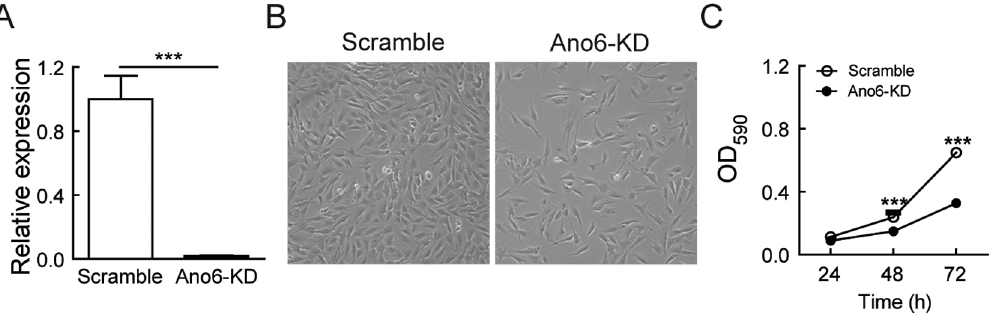
Figure 2. Effects of Ano6 -KD on the proliferation of C2C12 myoblasts. (A) Relative expression of Ano6 (normalized to GAPDH) examined by quantitative RT-PCR in C2C12 stable cells lines (Scramble [shSCR], Ano6 -KD). (B) Representative photographs of stable C2C12 cell lines expressing either a Scramble shRNA or the shRNA targeting Ano6 -KD 48 hours post plating. (C) Quantitative analysis of C2C12 myoblast proliferation using the MTT assay. Scale bar = 150 m m. ***p ,